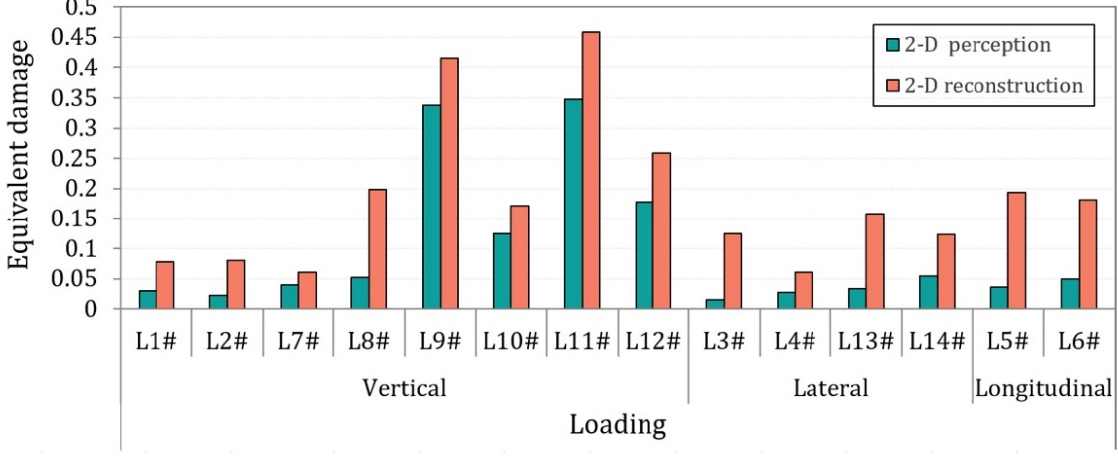
Figure 16. Maximum 2 ‐ D equivalent damage comparison of capture and reconstruction.